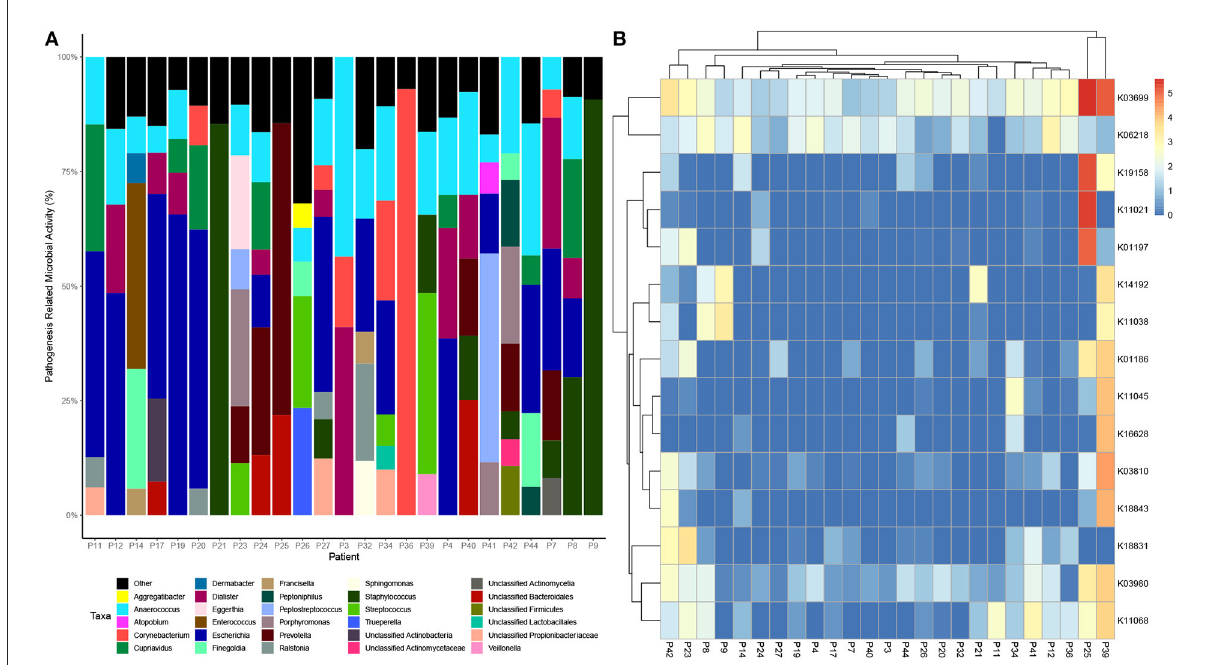
FIGURE2 Taxonomic and functional distribution of metatranscriptomic data associated with pathogenesis. (A) Bar chart highlighting taxonomy at the genus level that represent > 5% of pathogenic activity. (B) Heatmap highlighting the top 15 expressed transcripts across all samples normalized to